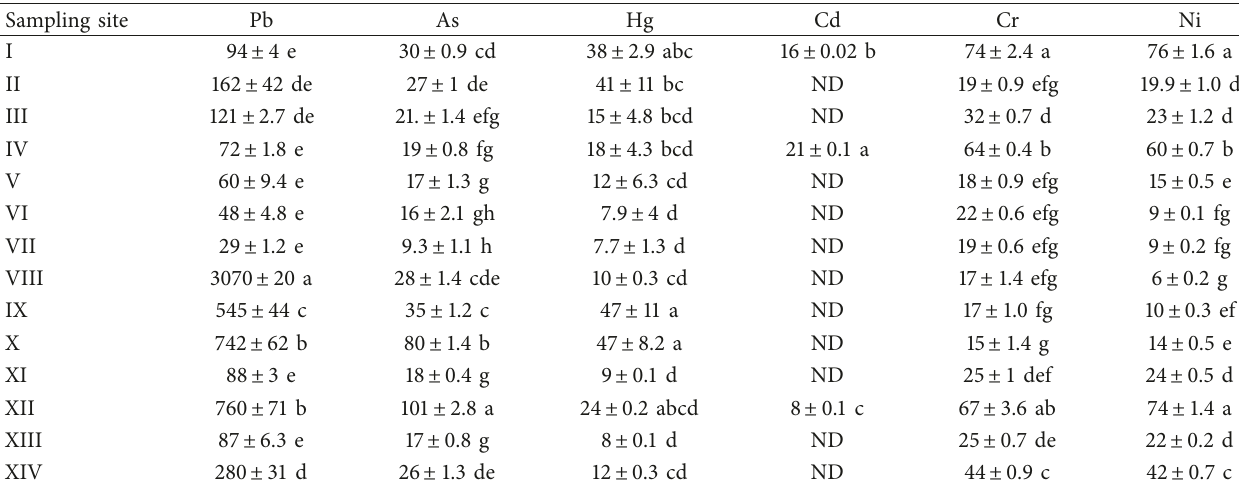
Table 2: Mean values and standard errors of heavy metal concentrations in soils and sediments from the La Zacatecana Lagoon. Sites denoted by different letters in the same column differ significantly at p < 0 . 05 in one-way ANOVA, according to Tukey’s post hoc analysis. Metal concentrations are expressed as mg · kg − 1 .